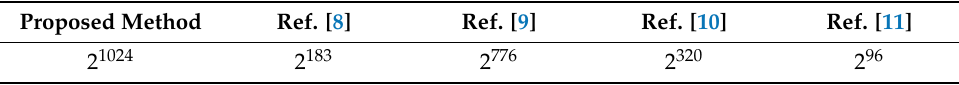
Table 2. Key size comparison with some novel pseudorandom number